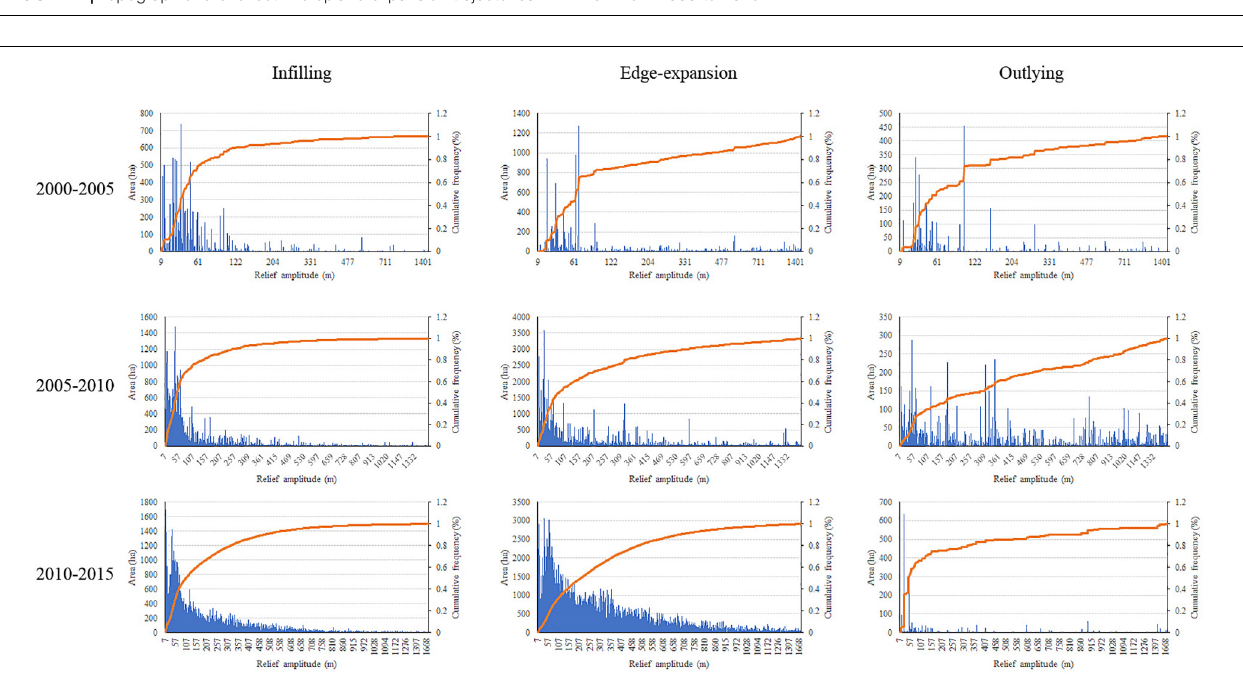
FIGURE 5 | Topographic relief effect in cropland expansion trajectories in MRYRUA from 2000 to 2015.